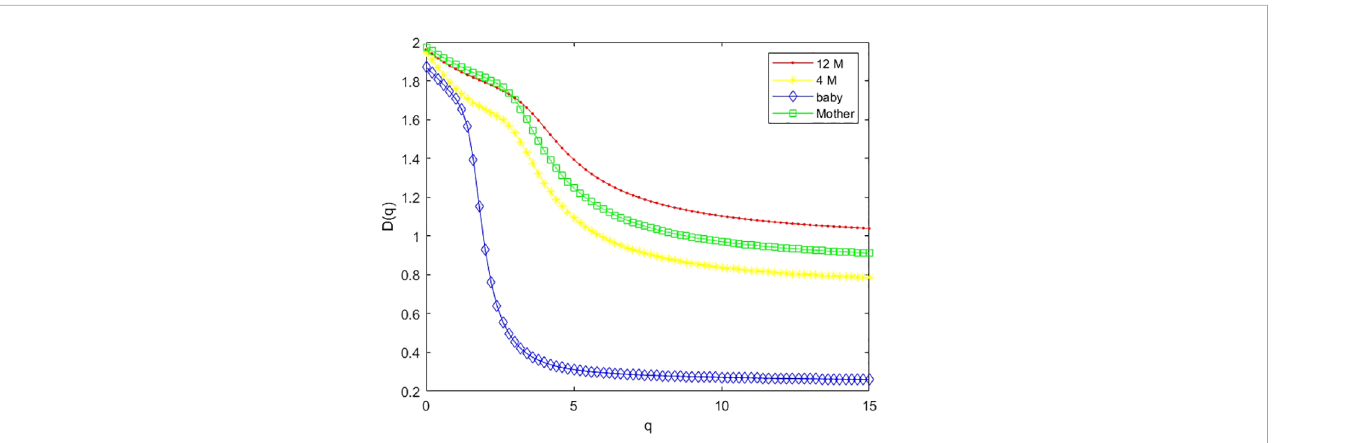
FIGURE 7 Multifractal dimension of the gut microbiome of the infant when he/she is 12 months old (12 M), 4 months old (4 M), and a newborn baby (baby), and her mother